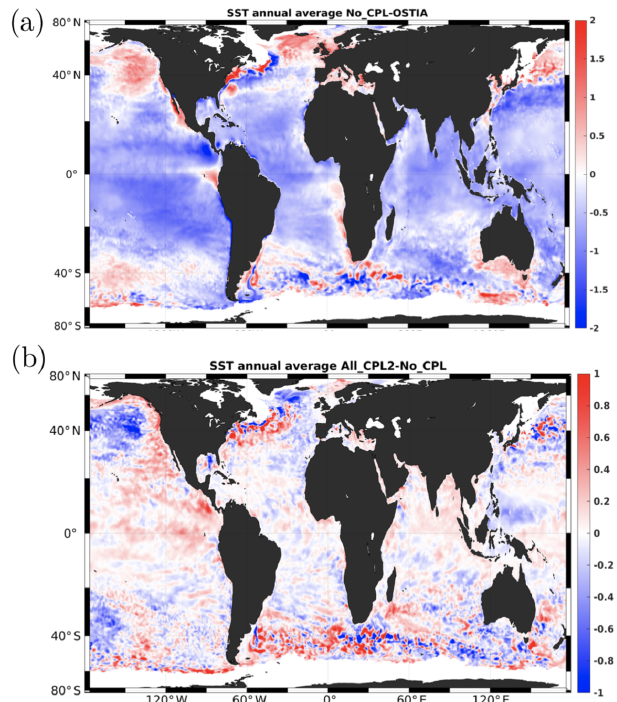
Figure 13. (a) Annual average of the differences between No_CPL and OSTIA sea surface temperatures ( ◦ C) for the year 2014 (posi- tive when the model is warmer). (b) Annual average of the differ- ence between All_CPL2 and No_CPL (positive when All_CPL2 is warmer).